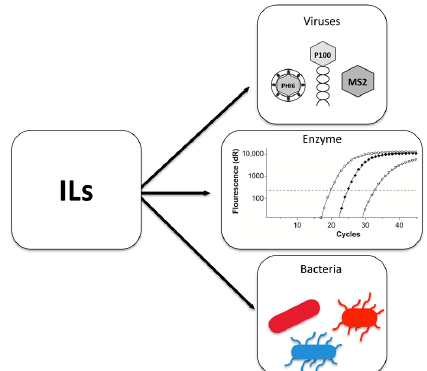
Figure 1. Overview of the biological test system. Virucidal effects of ionic liquids (ILs) (tested on viruses P100, MS2 and Phi6) and their toxicity (investigated by enzyme inhibition and minimum inhibitory concentration on the related host strains L. monocytogenes , E. coli and P. syringae ) were compared and used to predict effects of ILs on viruses.